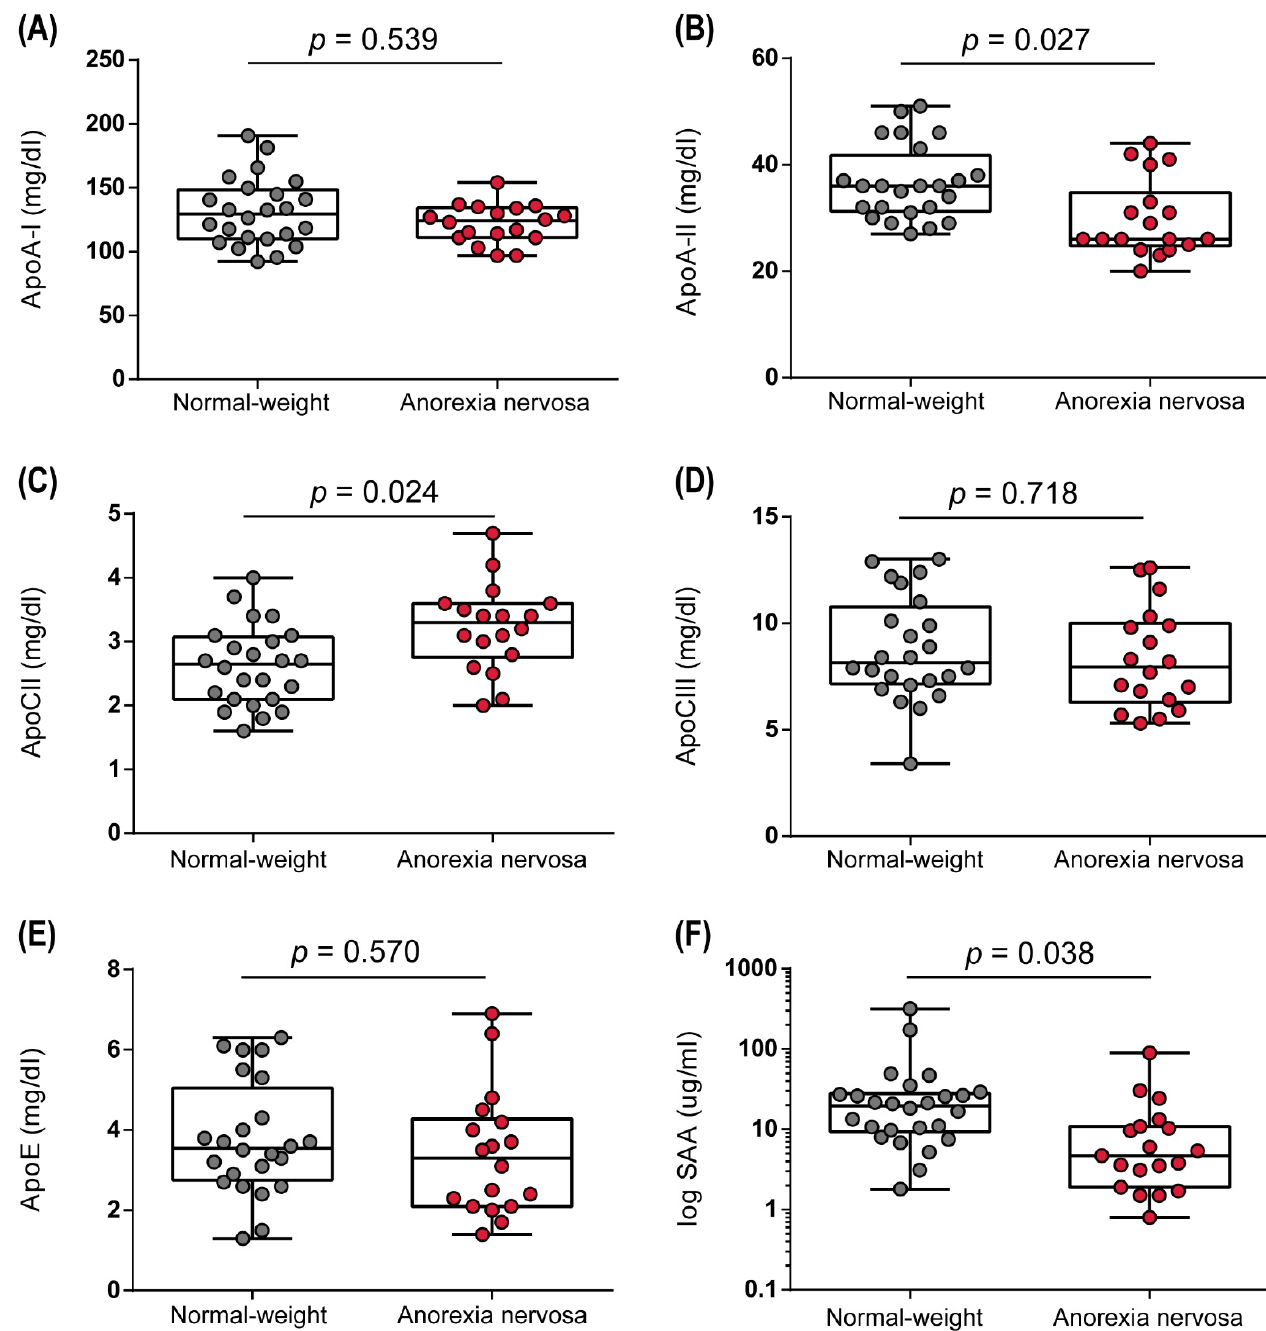
Figure 4. Apolipoprotein composition of HDL in normal-weight and anorexia nervosa women. HDL-associated proteins including apoA-I ( A ), apoA-II ( B ), apoC-II ( C ), apoC-III ( D ), apoE ( E ), and SAA ( F ) were determined in apoB-depleted serum. Depending on the normal distribution of the data, t-test or Mann–Whitney U test was used to analyze differences between the two groups. Individual data are presented on top of boxplots, displaying median, interquartile range, as well as minimum and maximum values. Adjusted p -values according to Benjamini–Hochberg are displayed.